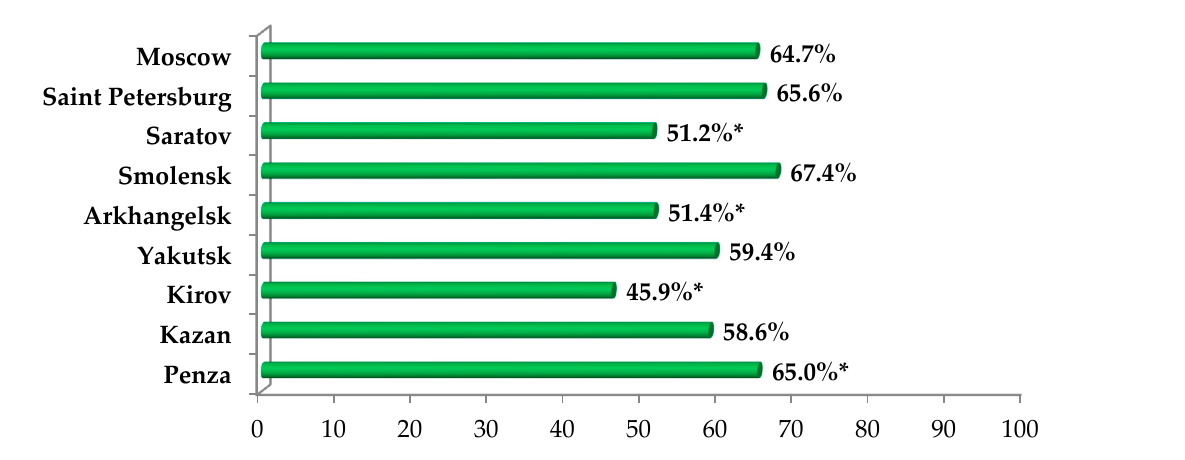
Vaccinated students' percentage Figure 9. The distribution of vaccinated medical students by Russian region. Note: *—the differences are significant, p < 0.05.